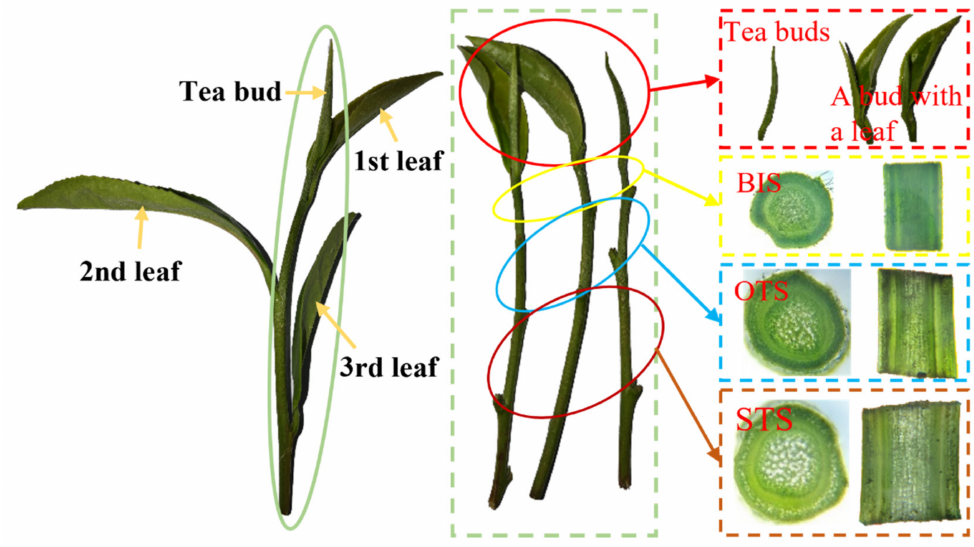
Figure 2. Structure of analyzed tea samples. BIS: stalks between buds and leaves; OTS: one and two leaves interstitial stalks; STS: stalks between the second and third